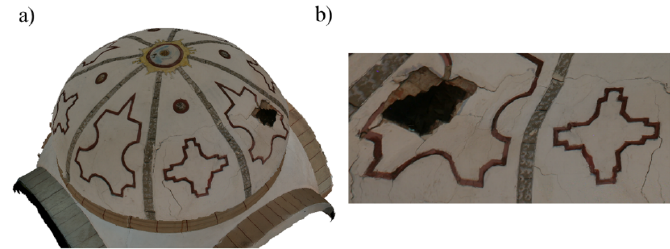
Figure 4. ( a ) 3D model obtained by the proposed methodology; ( b ) Detail view of the most damaged section through the texture model.